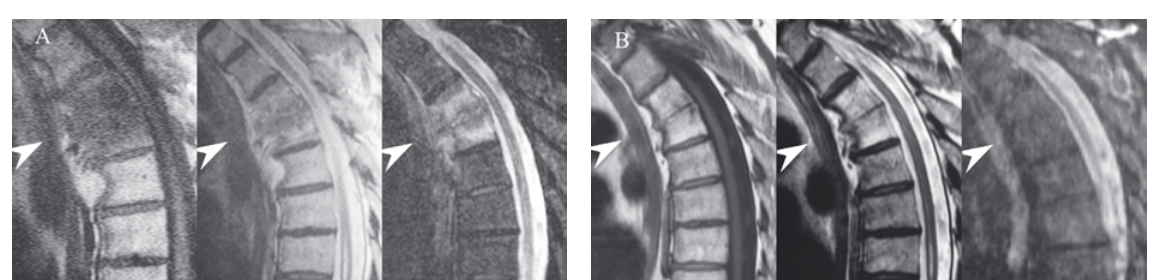
Figure 4. Case 2: A sagittal T1, T2-weighted and TIRM magnetic resonance images in the 9th month of the antituberculous treatment.